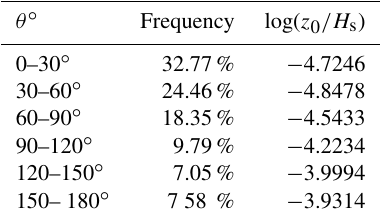
Table 3. Frequency measurement points in each alignment sec- tion and the dimensionless roughness length corresponding to the maximum probability for each section, for the combined ASIT and FINO1 data